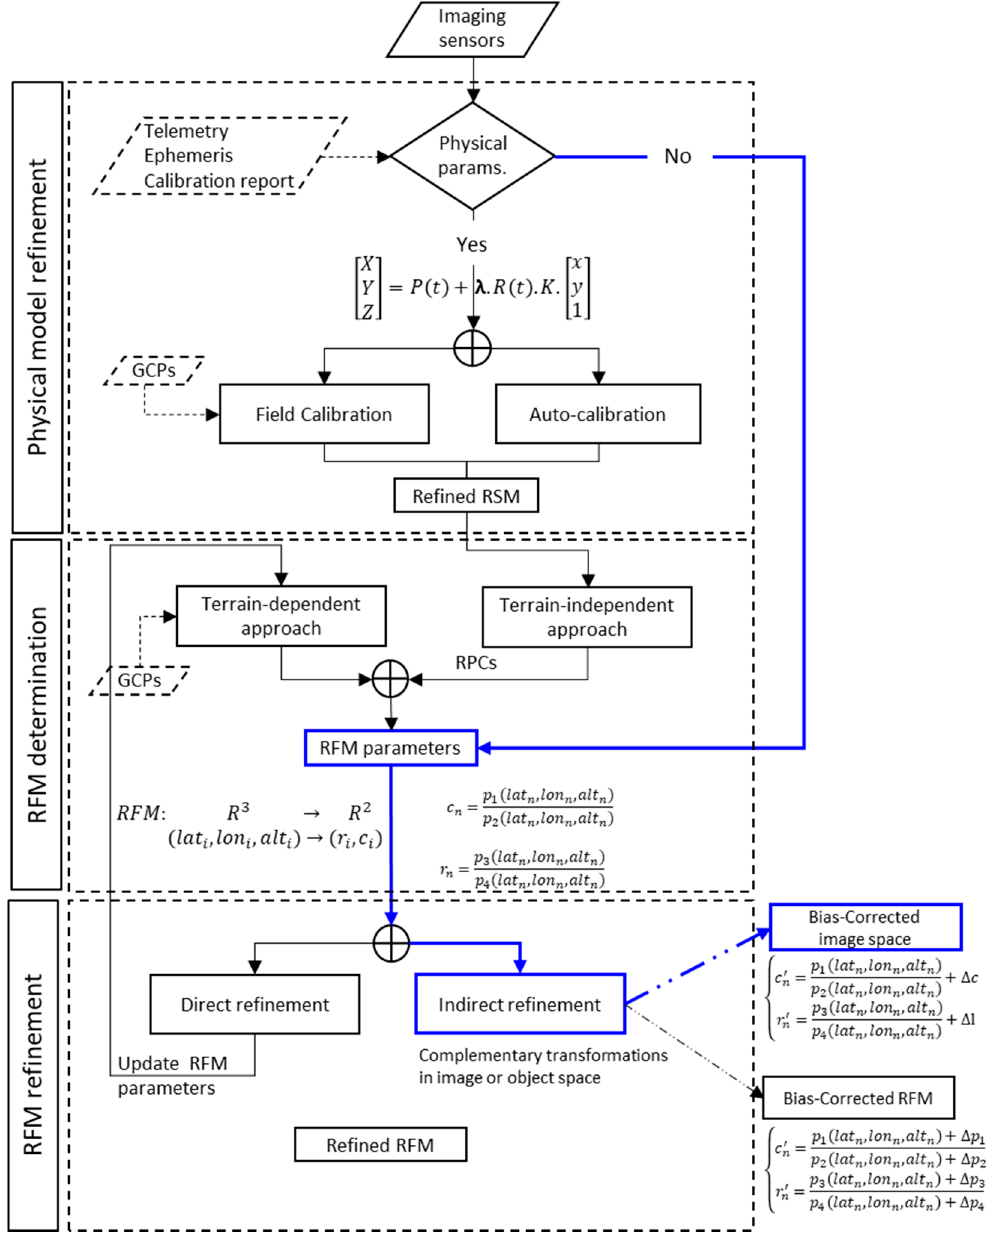
Figure 1. Workflow for image geometry refinement including physical model (Rigorous Sensor Model) and rational function model (RFM) approaches. The blue color pathway shows the processing path described in this study and is added as an additional module in the COSI-Corr package.